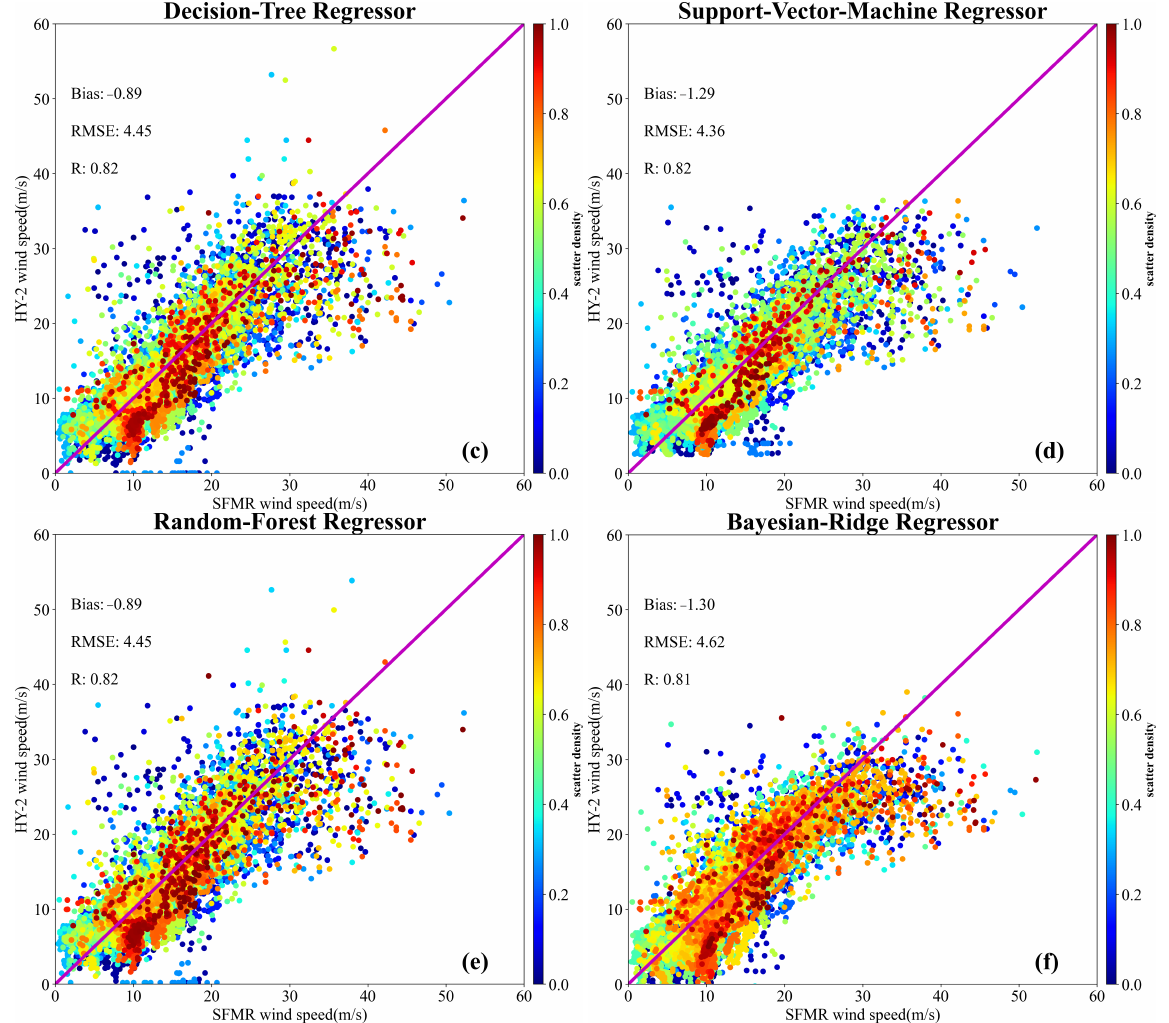
Figure 10. Scatterplots of the revised high wind speed measurements from HY-2B/C/D scatterom- eters by machine learning with respect to those from SFMR measurements. ( a ) BP-NN algorithm; ( b ) KNN algorithm; ( c ) DT algorithm; ( d ) SVM algorithm; ( e ) RF algorithm; and ( f ) BR